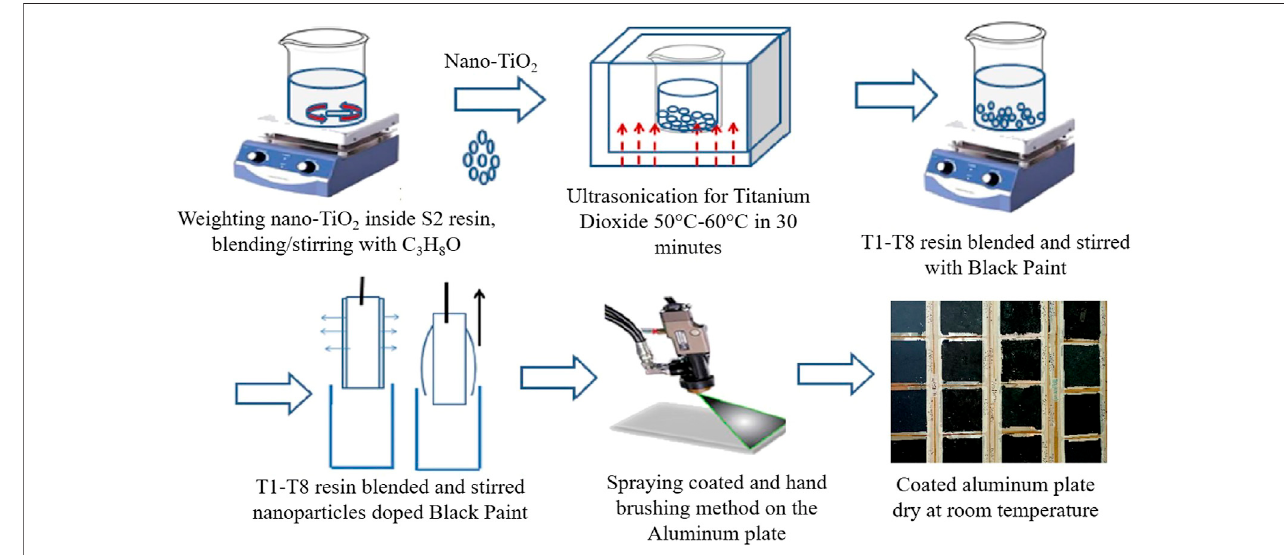
FIGURE 1 | Sample